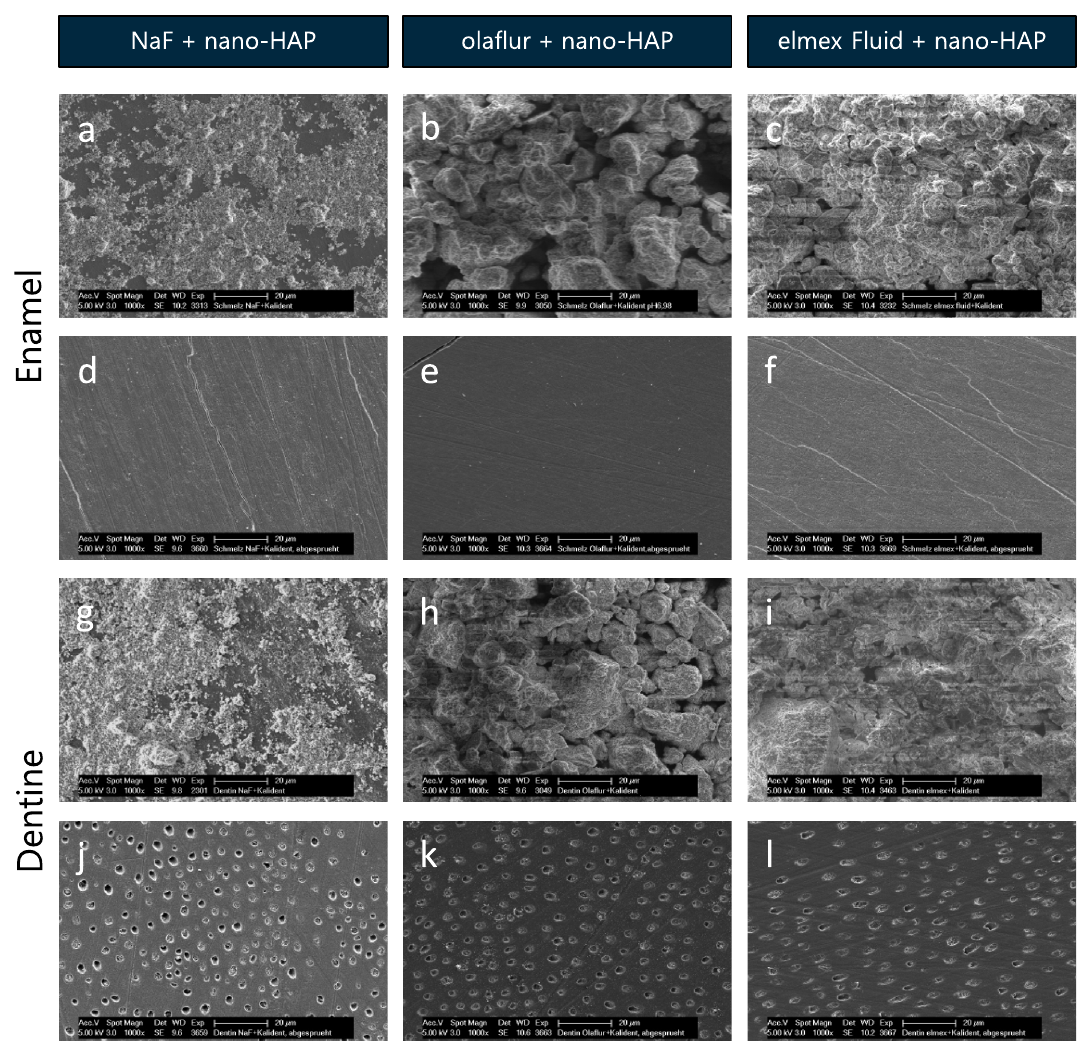
Figure 5. SEM figures at 1000-fold magnification of enamel ( a–f ) and dentine ( g,l ) samples after 5 min incubation in aqueous nano-HAP solution combined with sodium fluoride ( a,g ), olaflur ( b,h ), elmex Fluid ( c,i ) and subsequent 20 s spraying with the multifunctional syringe ( d–f,j–l ). The images reveal nano-HAP agglomerates masking the surface, which neither resemble the nano-HAP particles nor the calcium fluoride globules. After spraying, a polished enamel and dentine surface without any precipitates is visible. Nano- HAP hydroxyapatite nanoparticles, NaF sodium